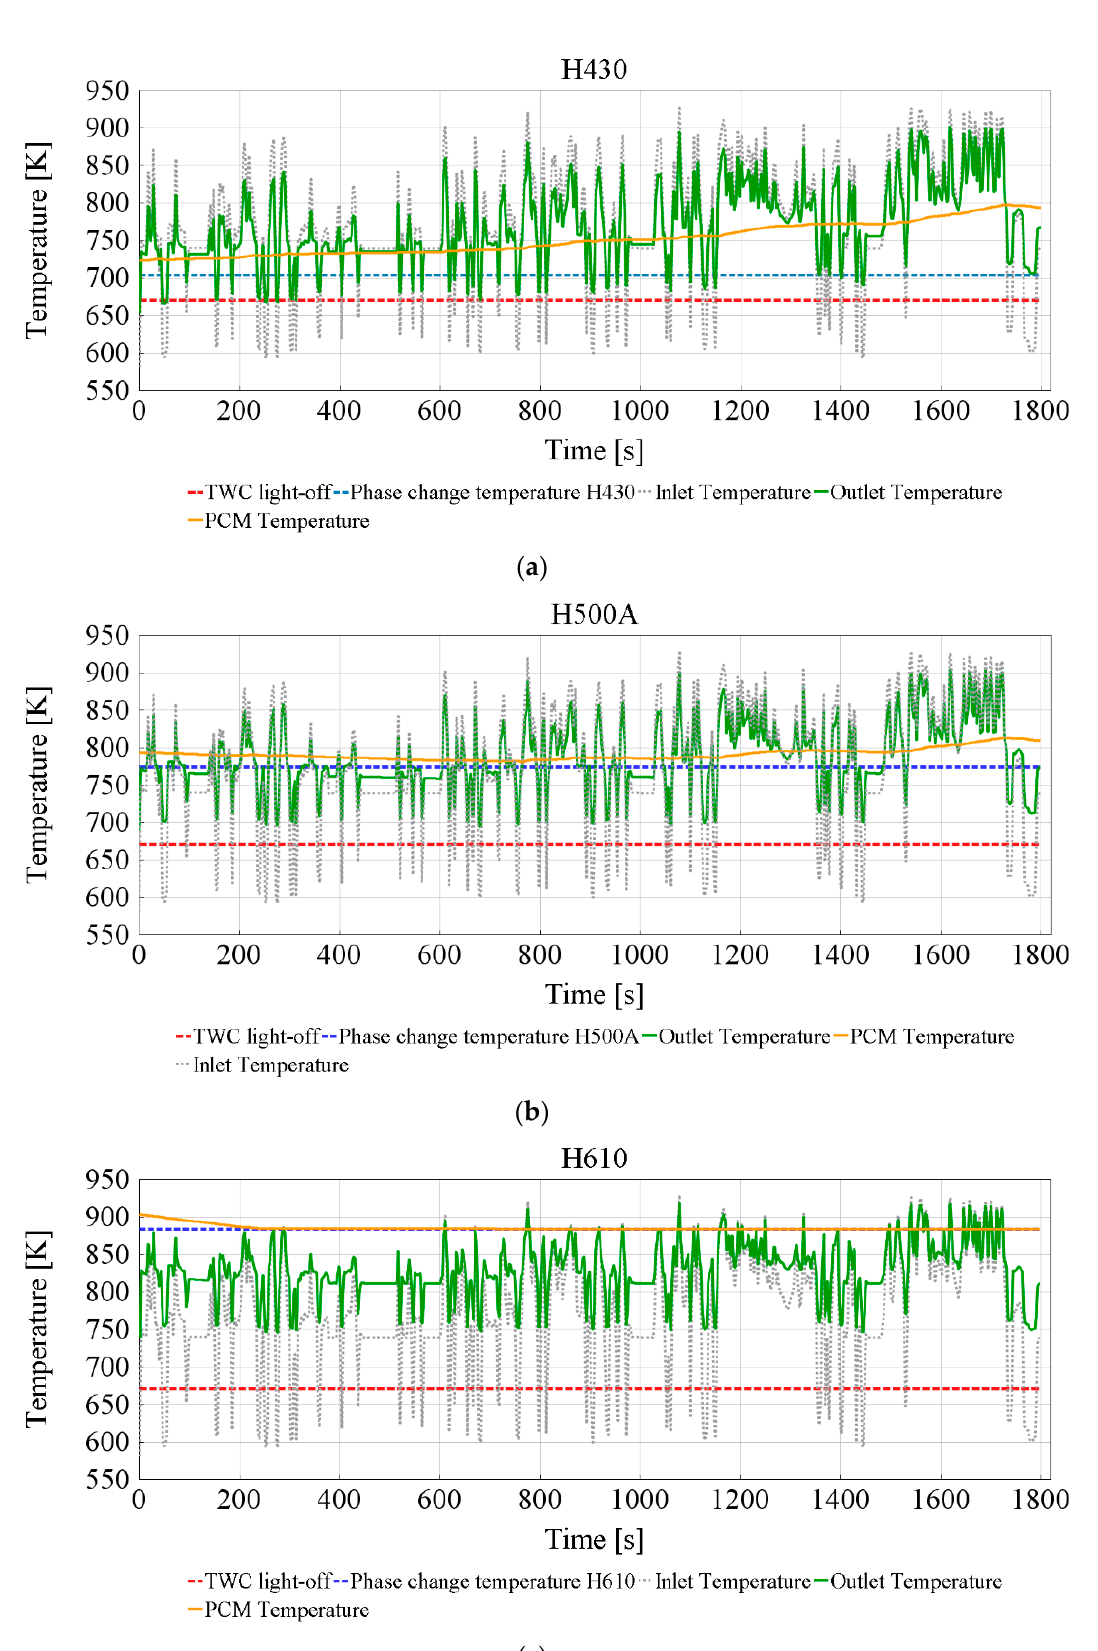
Figure 9. Effect of TESS with different PCM: ( a ) H430; ( b ) H500a; ( c ) H610. On the other hand, the PCM H610’s phase change temperature is too high—the mean temperature of the exhaust gas is lower than this value. This means that TESS is discharging during the whole driving cycle, however, if the TESS is fully charged, it also stabilizes the exhaust gas temperature.